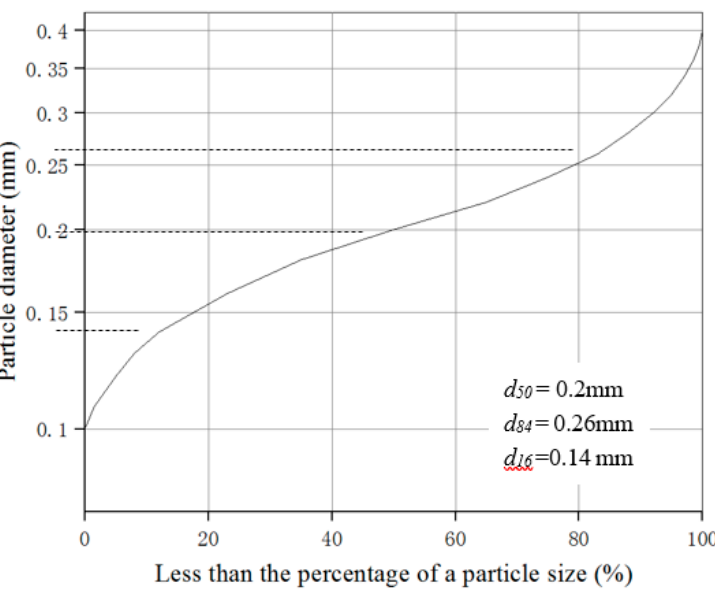
Figure 2. Cumulative frequency curve of sand particle size distribution (Cui et al. [24]).